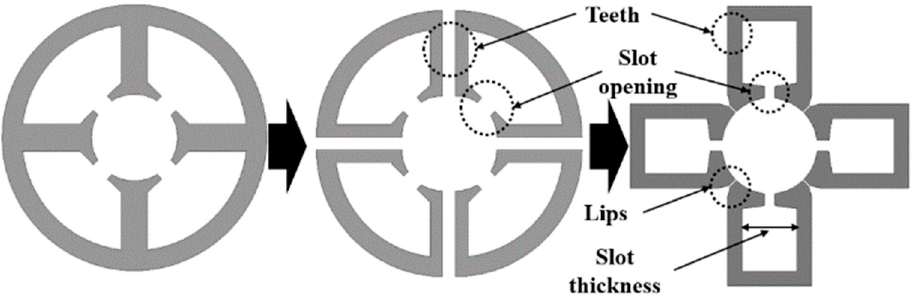
Figure 4. STBM creation process.